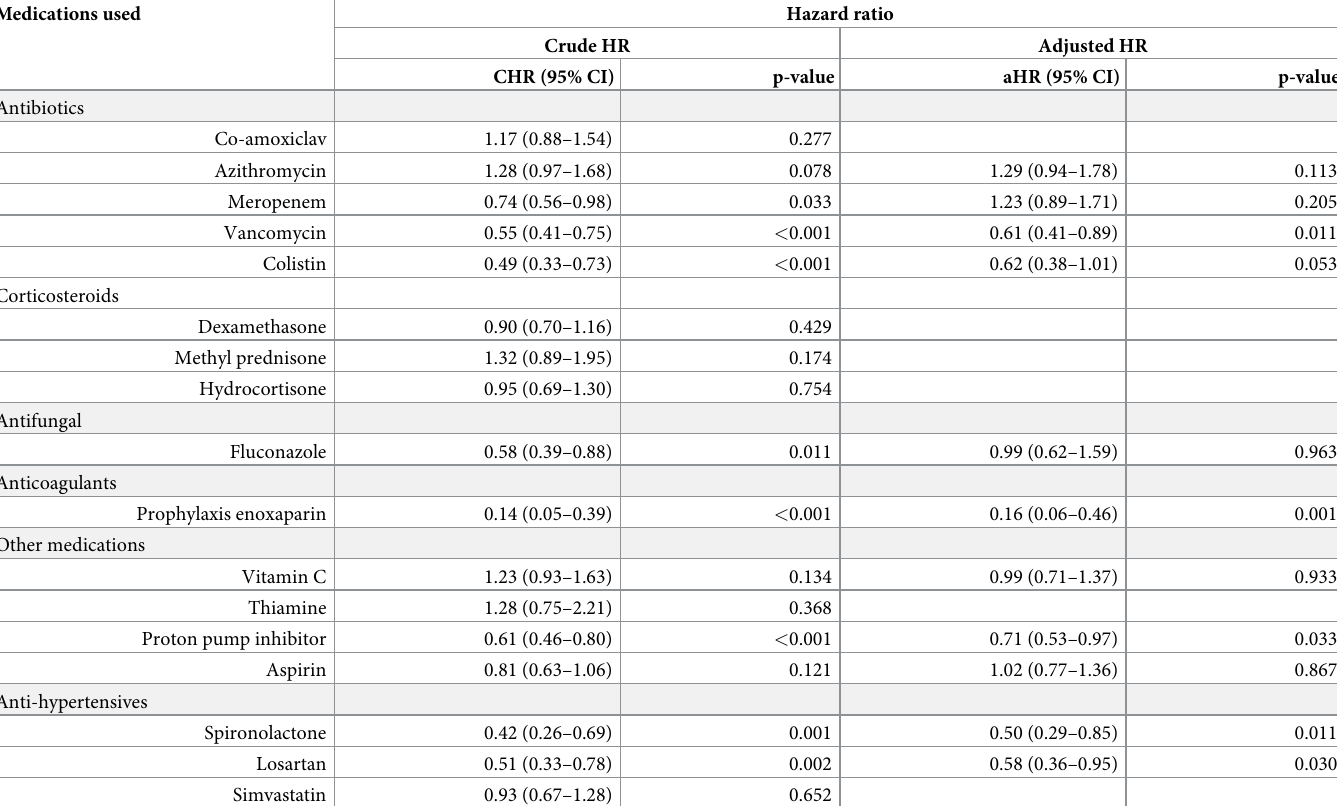
than the overall estimate in this systematic review [30], and the South African COVID-19 admission mortality rate was 26% during the study period [31]. The increased risk of in-hospi- tal death associated with patients who were older was further augmented by the presence of one or more chronic comorbidities. There were significant gender differences in discharge Table 5. Medication use associated with hazard ratio among COVID-19 patients admitted in ICU. Medications